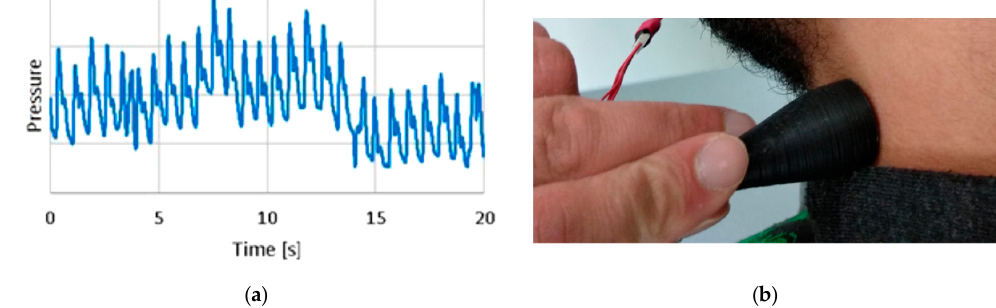
Figure 5. Pressure waveform ( a ) measured with sensor probe ( b ) on the carotid artery.